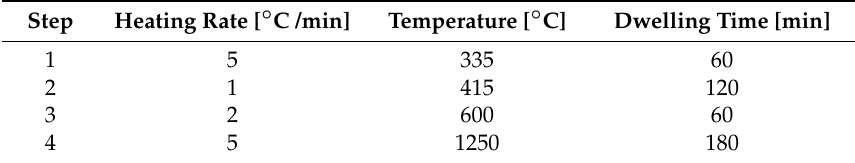
Table 2. Schedule for the de-binding process for the complete removal of the photo cured polymers and additives in the green